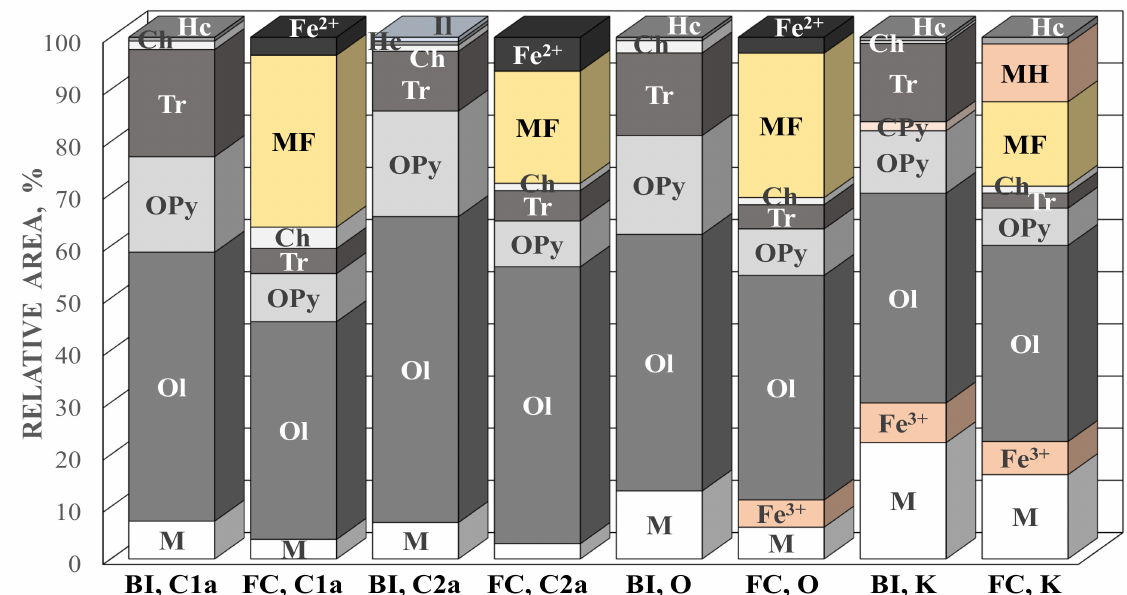
Figure 52. Comparison of the modal phase analysis of the bulk interior ( BI ) and the fusion crust ( FC ) from Chelyabinsk LL5, No 1a and No 2a ( C1a and C2a ), Ozerki L6 ( O ) and Kemer L4 ( K ) on the basis of the relative component areas obtained from the Mössbauer spectra. M —Fe-Ni-Co alloy components, Ol —olivine, OPy —orthopyroxene, CPy —clinopyroxene, Tr —troilite, Ch —chromite, Hc —hercynite, Il —ilmenite, MF —magnesioferrite, MH —maghemite, Fe 3+ —ferric compound(s), Fe 2+ —ferrous compound(s). Adapted from [106] with incorporation of new data from [99,100].